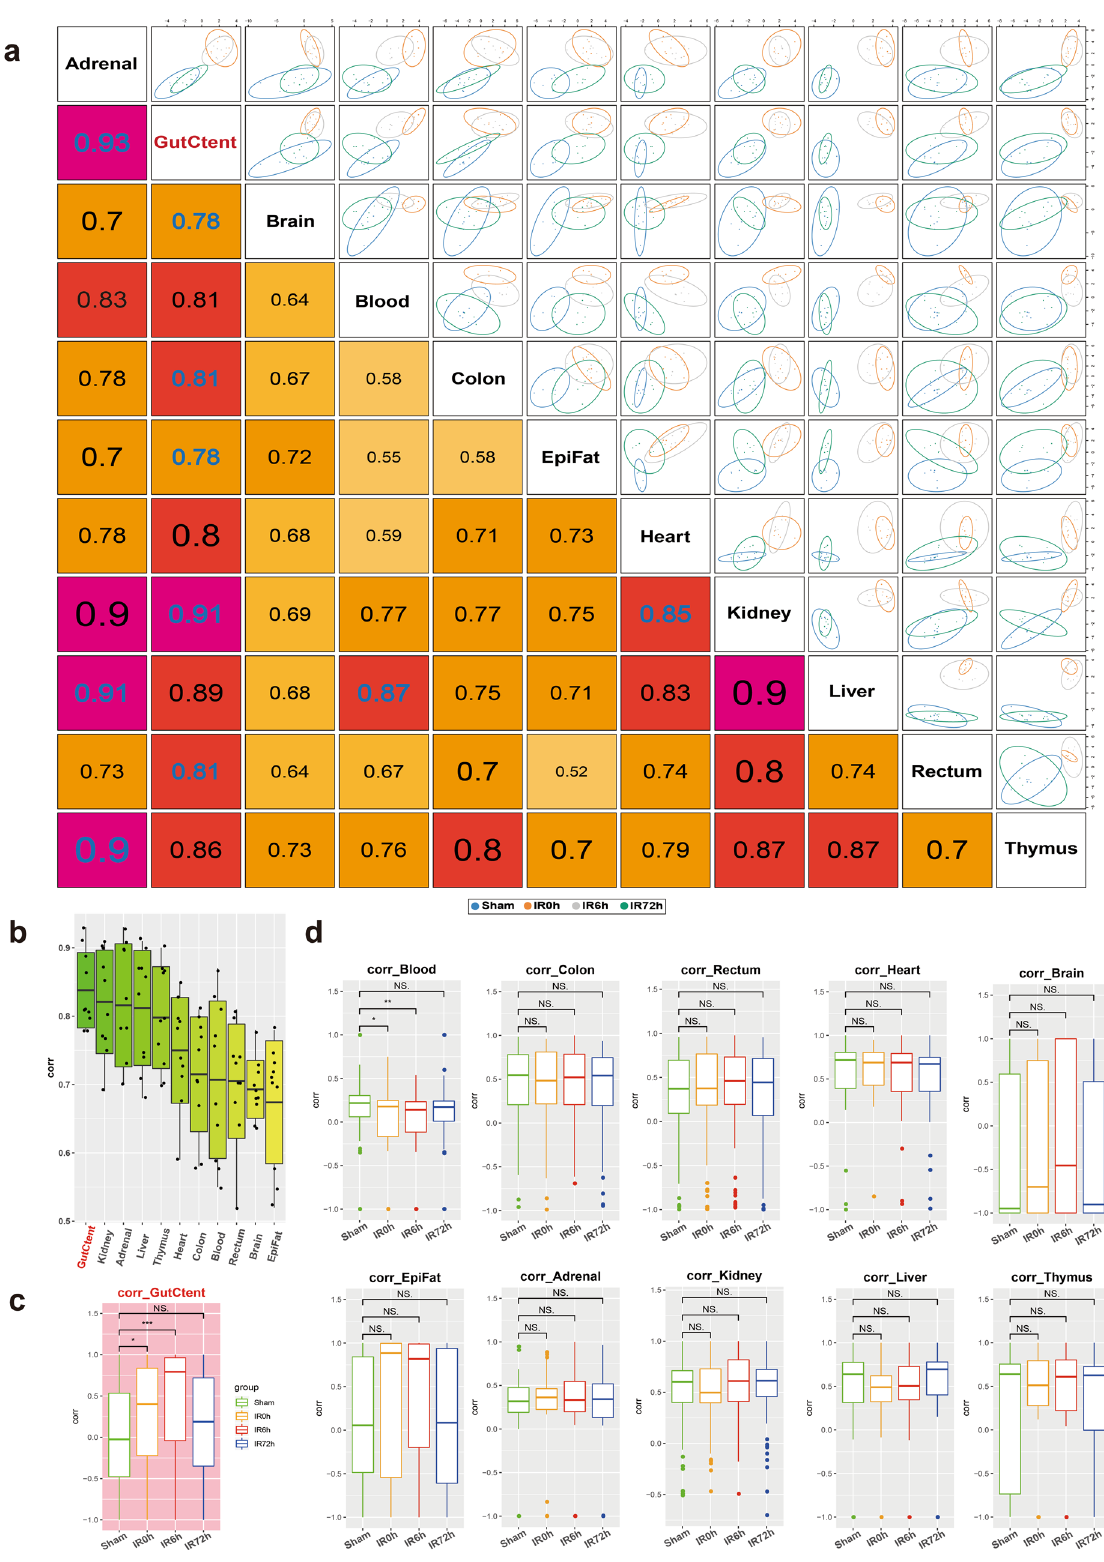
histamine, acetylcholine, sphingosine, N G , N G -dimethyl-L-argi- nine (ADMA), and N -(omega)-Hydroxyarginine (Fig. 4c). Out- standingly, several of them are associated with neurotransmitters. For example, acetylcholine and histamine are neurotransmitters. ADMA is an endogenous nitric oxide synthase inhibitor, 36 and